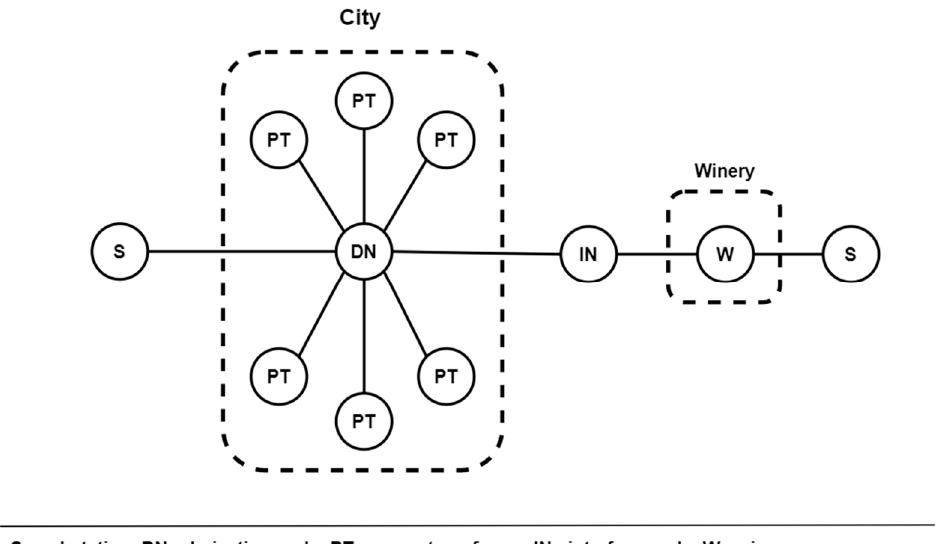
Figure 9. Local power grid layout assumed for this work/Reguengos de Monsaraz, which was implemented in calliope. Electricity can be generated in the substation (i.e., the traditional electricity supply/from the supply grid) and in the power transformers and winery (by means of PV), with the last two also incorporating their respective electricity demand.